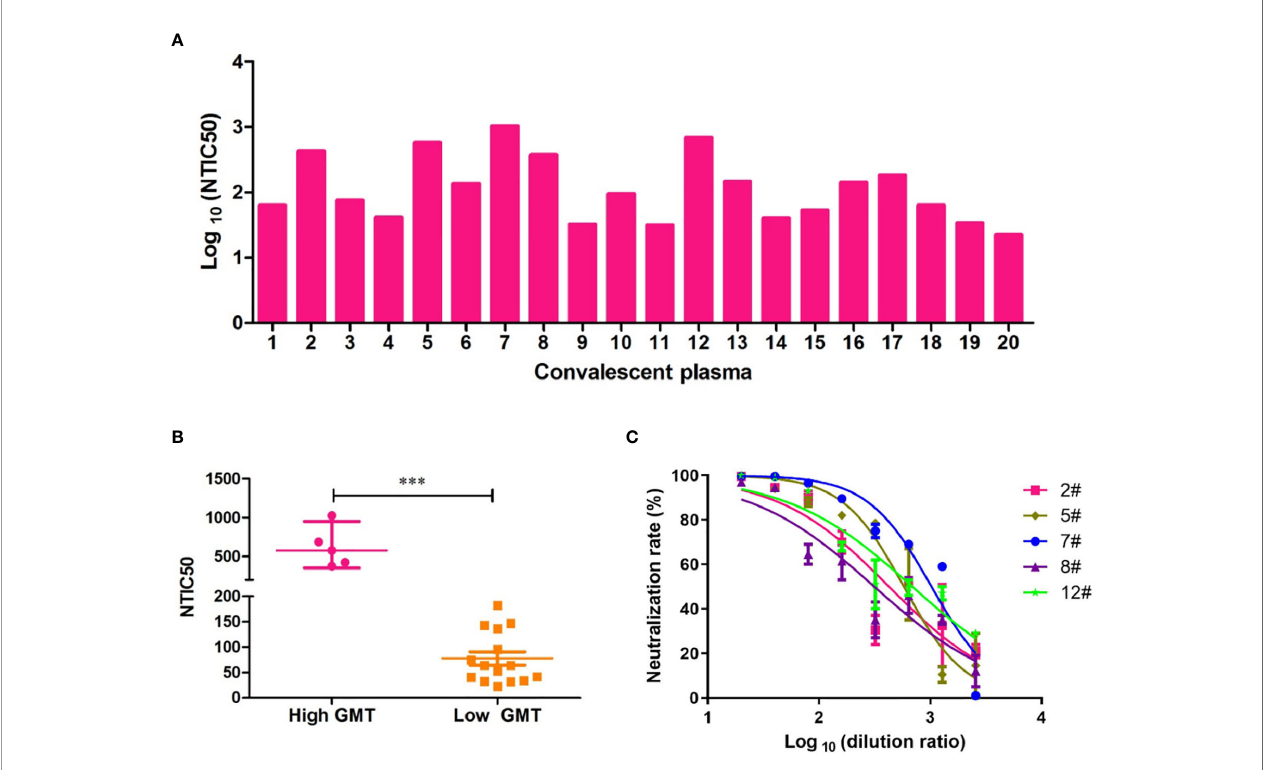
FIGURE 3 | Neutralization titers of convalescent plasmas against pseudovirus bearing the Wuhan reference spike protein. (A) Neutralization titer of 50% Wuhan pseudovirus inhibition (NTIC50) of 20 plasma samples from convalescent COVID-19 patients. (B) Clustering analysis in higher and lower GMT convalescent plasma samples. The difference of GMT in two groups was tested for statistical signi fi cance with a Mann-Whitney U test in the GraphPad Prism 8. Differences were considered statistically signi fi cant at *** p < 0.001. (C) Neutralization curves of the fi ve convalescent plasma samples (2#, 5#, 7#, 8#, and 12#) that show a higher neutralization titer than others against the Wuhan